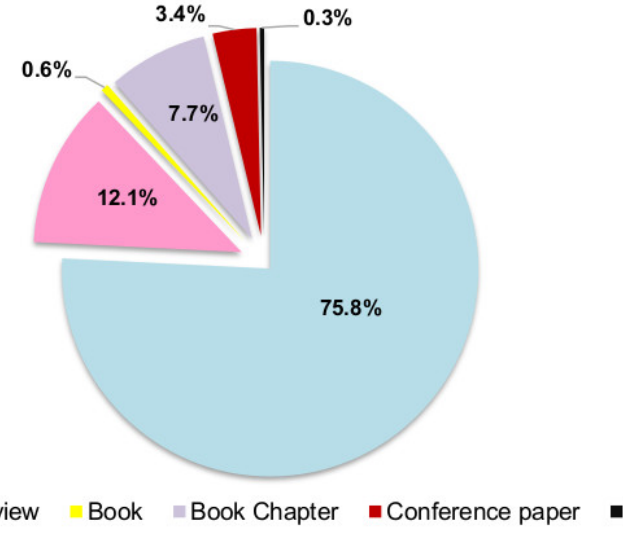
Figure 2. Distribution of different types of documents.